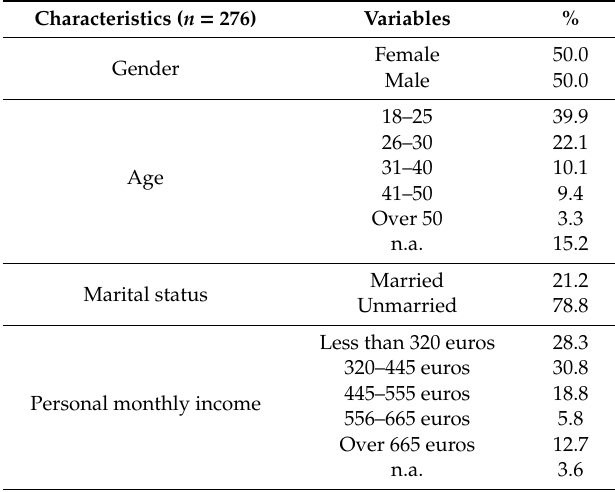
Table 2. Socio-demographic characteristics of the respondents.